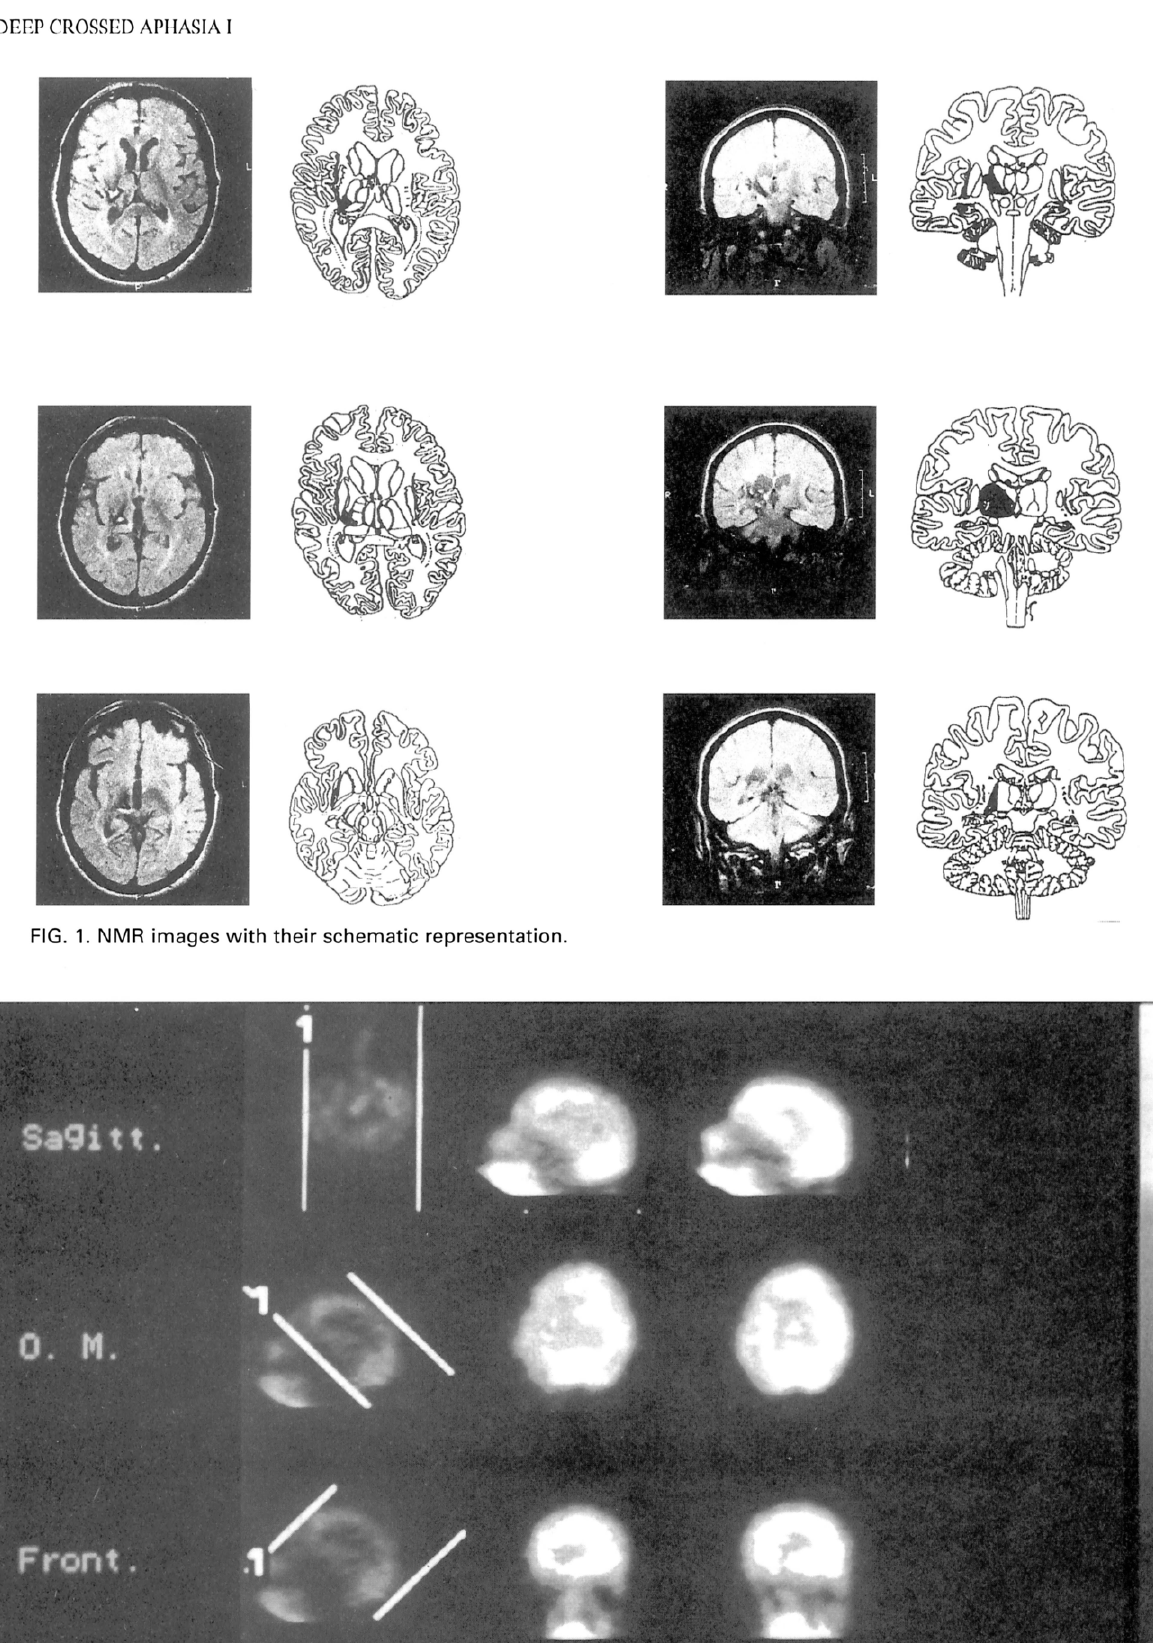
FIG. 2. SPECT study. Severe cortical and subcortical hypoperfusion in the right hemisphere is